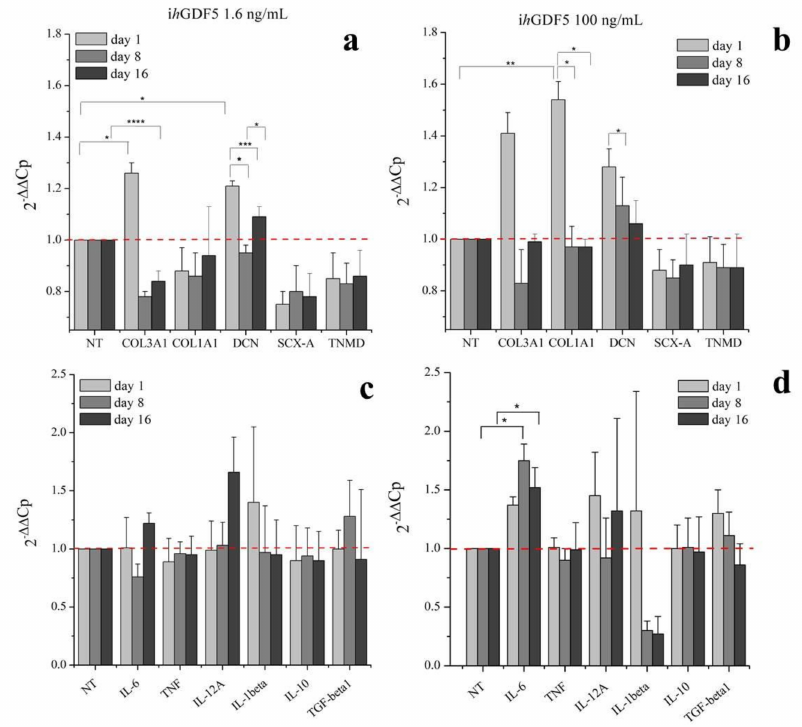
Figure 1. Gene expression profiles for tenogenic markers and pro-inflammatory and anti-inflammatory cytokines by hBM-MSCs treated with 1.6 ng / mL ( a , c ) and 100 ng / mL ( b , d ) of ihGDF-5 in monolayer 2D culture up to 16 days. mRNA levels of COL1A1, DCN, SCX-A, and TNMD were considered as tenogenic markers and COL3A1 selected as negative ones; pro-inflammatory (IL-6, TNF, IL-12A and IL-1 β ) and anti-inflammatory (IL-10 and TGF- β 1) cytokines were monitored. ihGDF-5 not had significant impact on genes expression, especially at the lower concentration tested. Untreated cells for matched time-points were used as control. * ≤ 0.05; ** < 0.01; *** < 0.005; **** < 0.001 N = 3 (biological replicates); n = 3 (technical